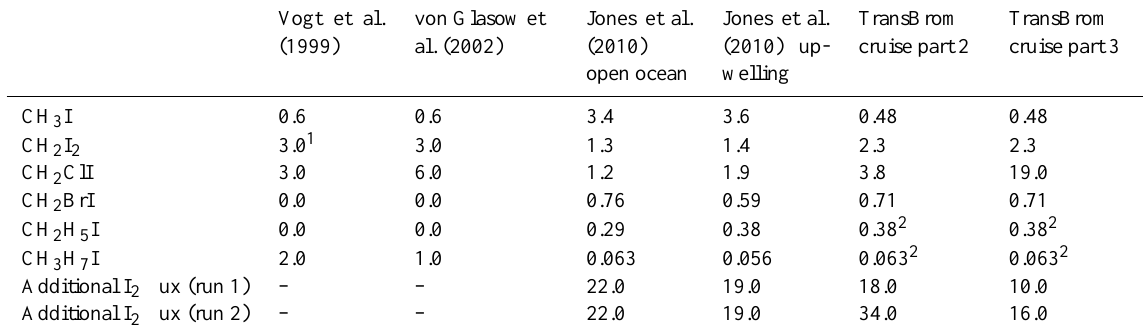
Table 3. Iodocarbon fluxes in units of 10 7 moleccm − 2 s − 1 calculated from the data of previous studies and those collected during the TransBrom cruise part 2 and 3.